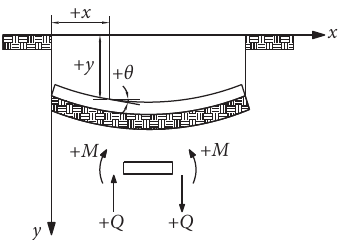
Figure 26: Schematic diagram of elastic foundation beam